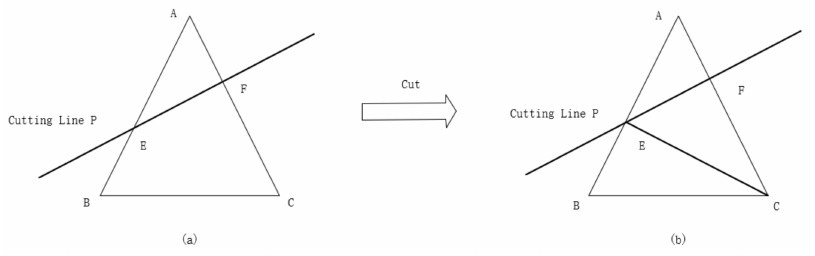
Figure 7. Triangle clipping method 1. ( a ) Triangle before cutting and ( b ) triangle after